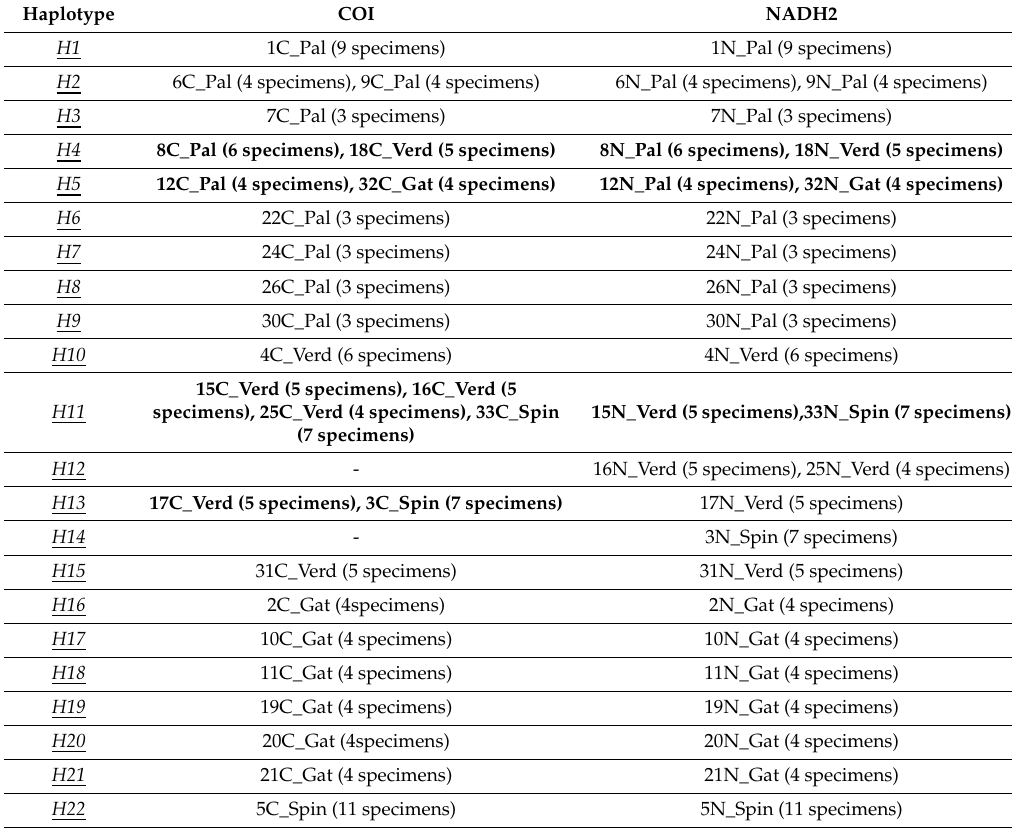
Table 3. Summary of groups of identical haplotypes for COI and NADH2 markers. Groups of haplotypes including samples originally labelled as di ff erent species are indicated in